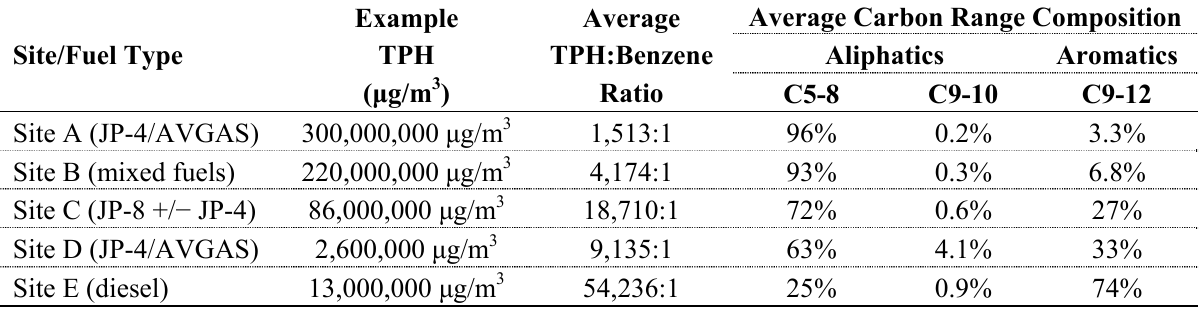
Table 9. Example TPH concentration in soil vapor, average TPH:Benzene ratio and TPH carbon range makeup of soil vapor samples collected in the Hawaii DOH petroleum vapor study (based on summa canister, TO-15